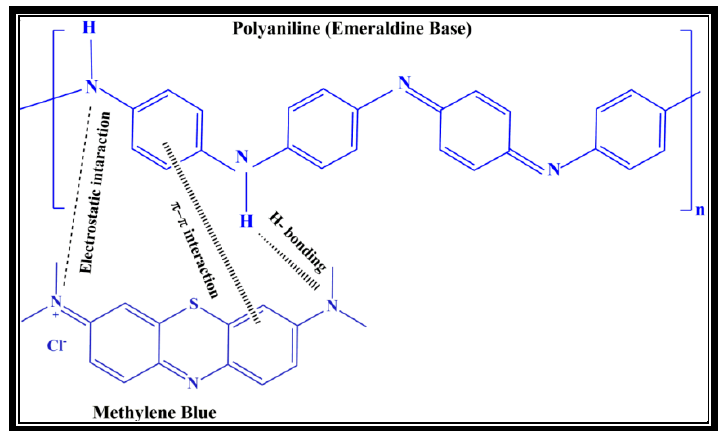
Figure 6. Schematic representation of interactions in the PNB–MB adsorption system.